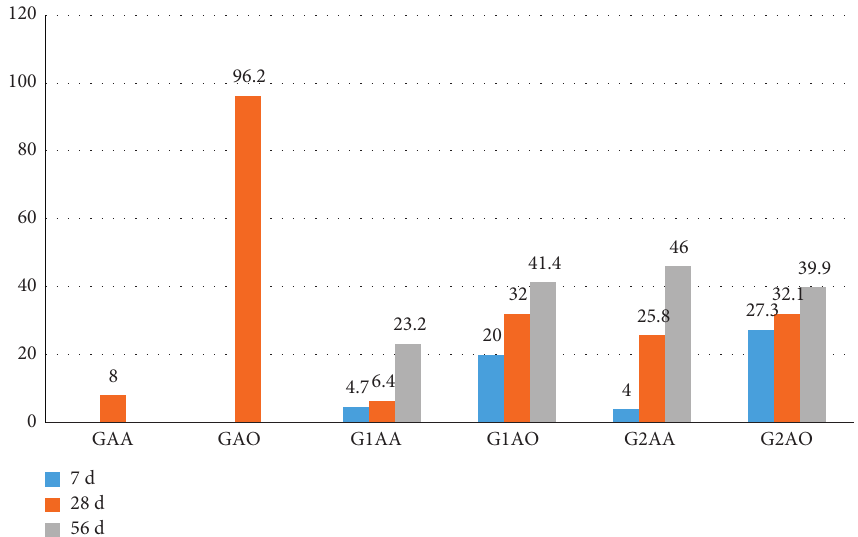
Figure 7: Effect of the curing condition on the compressive strength of